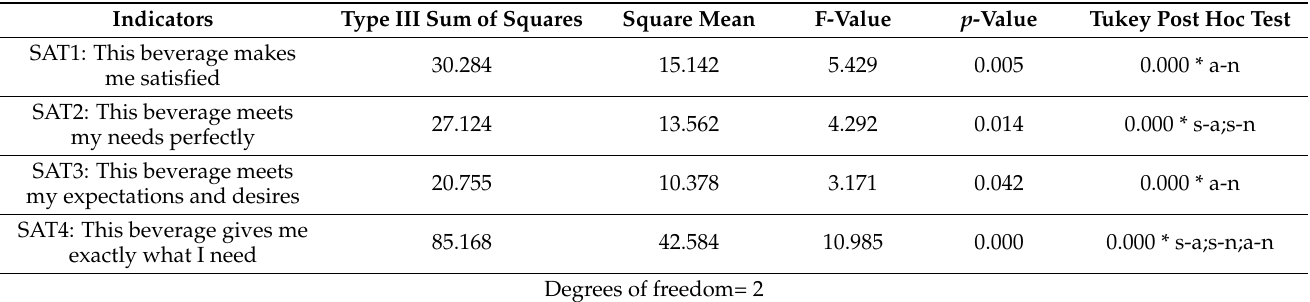
Table 7. Univariate tests and comparisons for